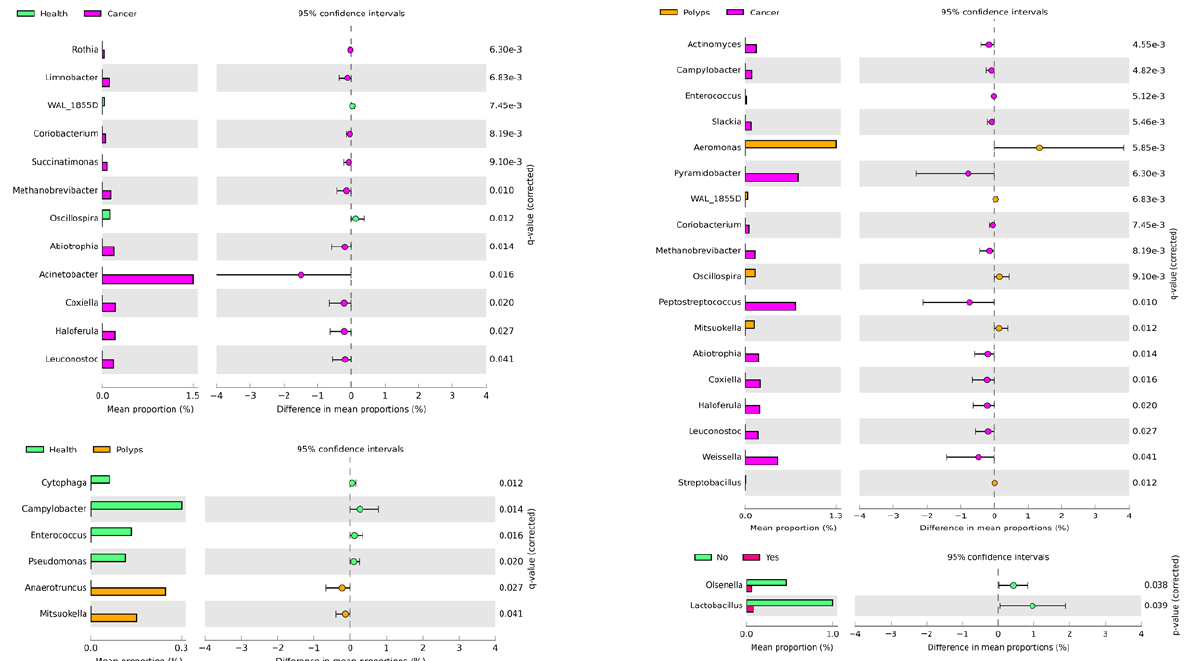
Figure 4. The post hoc plots of enriched bacterial genera among three health conditions (healthy, polyps, and cancer). The left side of these figures shows the abundance ratio of differentially enriched bacterial genera. The right side represents the significant difference at p < 0.05, whereas the middle one indicates the mean proportion of differentially enriched bacterial genera in the 95% confidence interval.